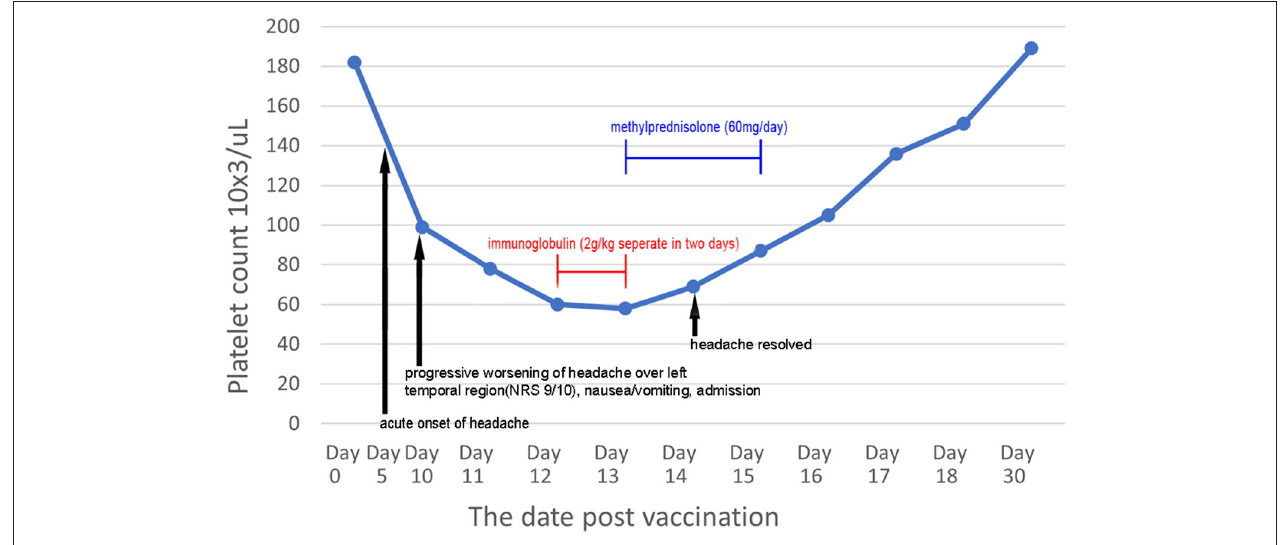
FIGURE 2 | Serial serum platelet count post-vaccination and chronological evolution of symptoms after steroid treatment and high-dose immunoglobulin.